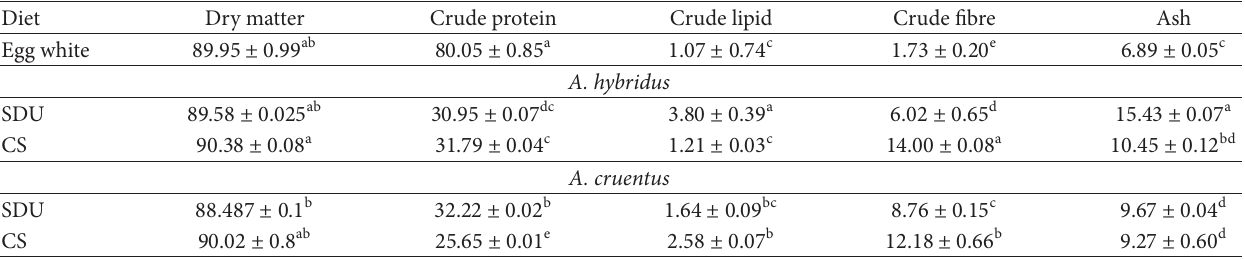
Table 3: Proximate composition (g/100g dry matter) of protein of reference (egg white) and differentially processed A. hybridus and A. cruentus